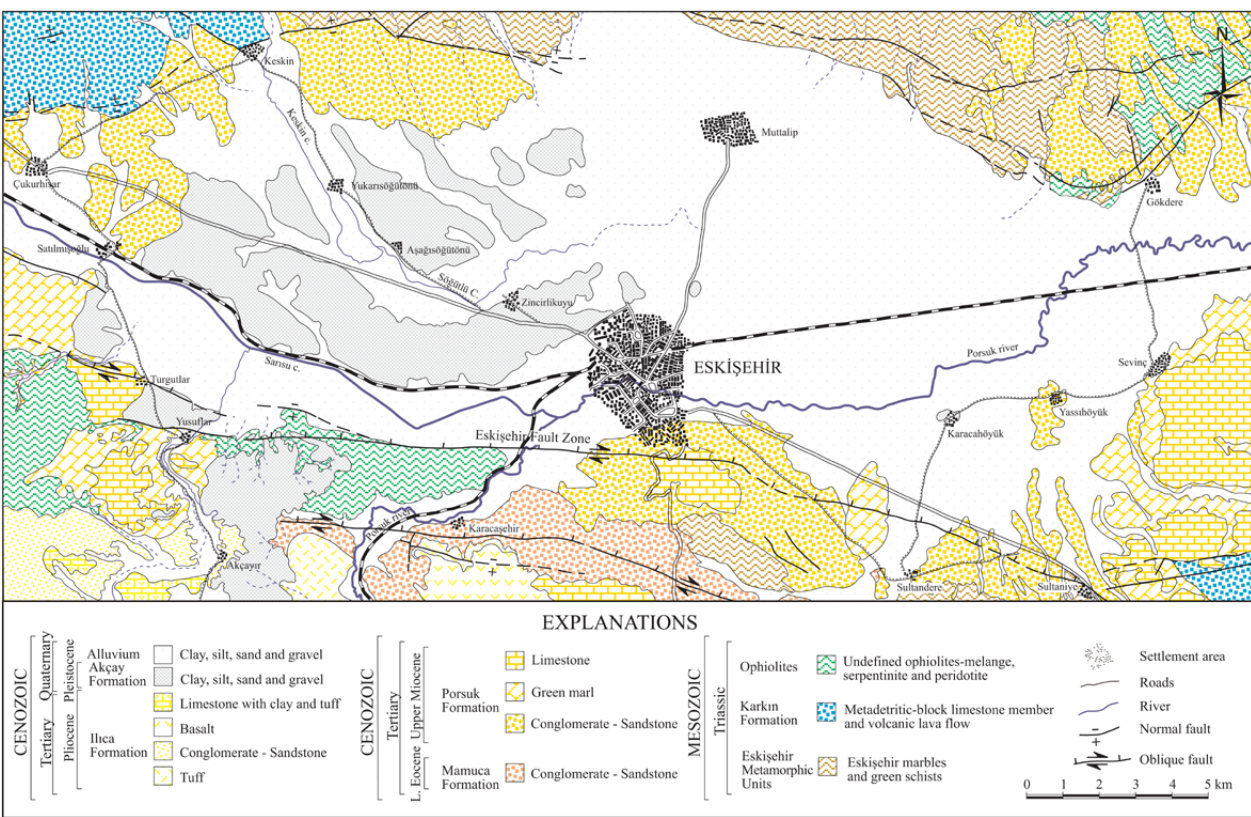
Fig. 2. Generalized geological map of Eskisehir and its vicinity (Orhan,